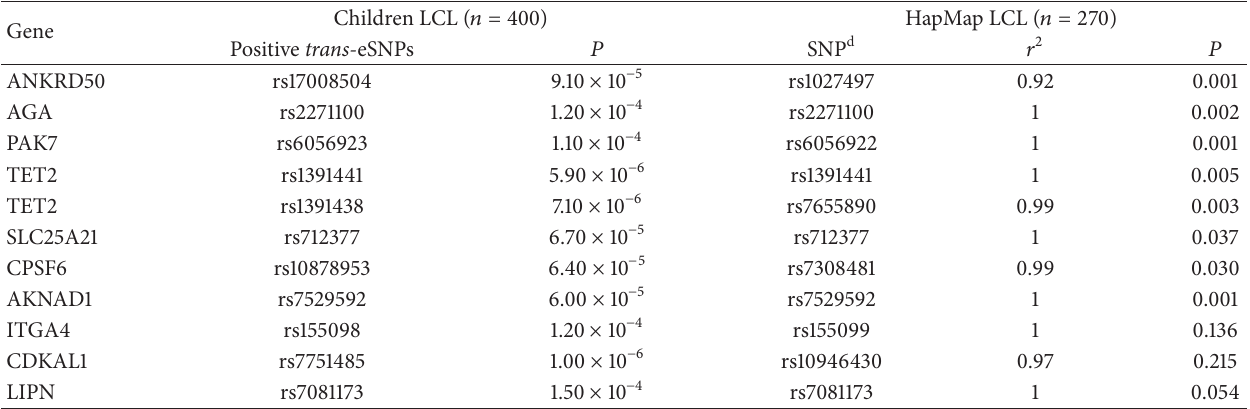
Table 2: Correlation between genotypes of the positive trans -eSNP with ATG5 expression in public databases.